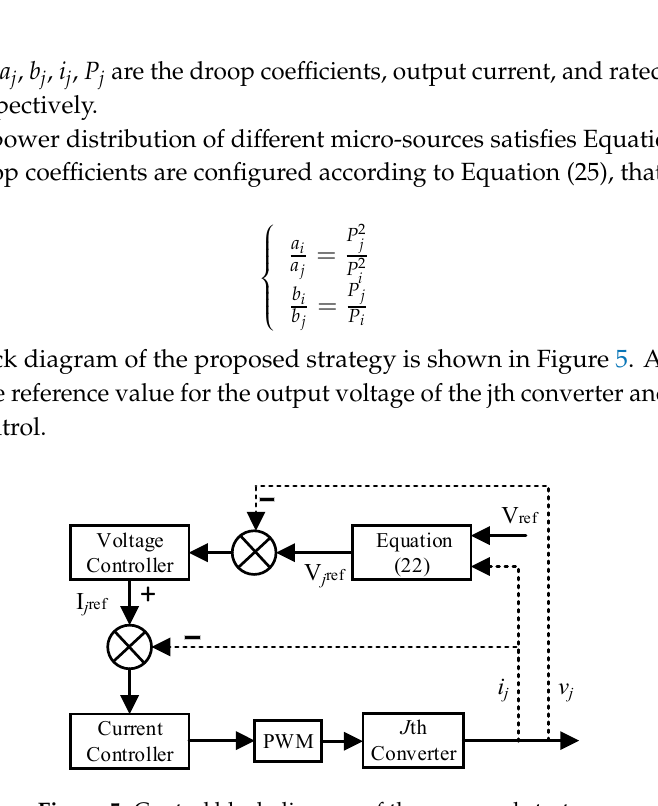
Figure 5. Control block diagram of the proposed strategy.